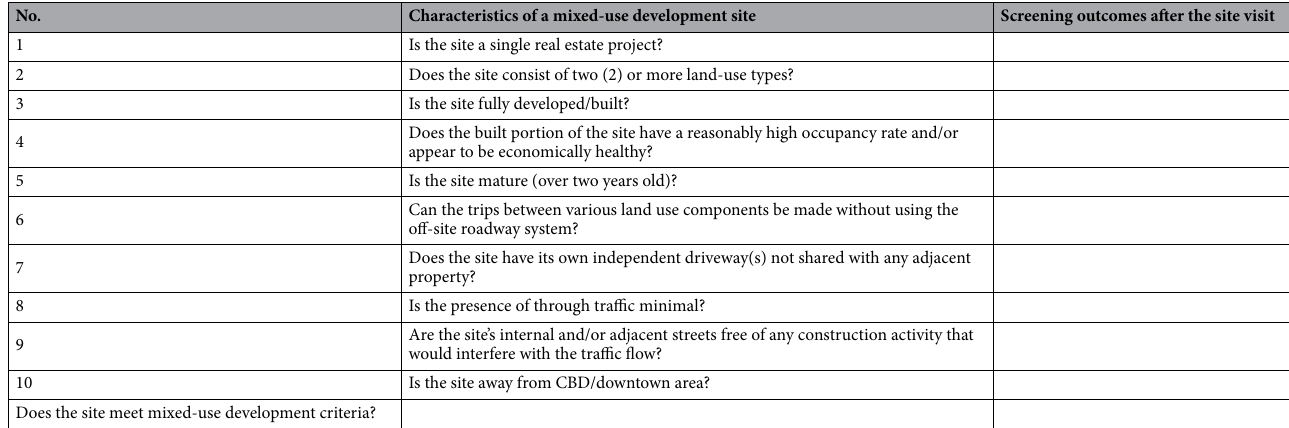
Table 1. Site selection criteria